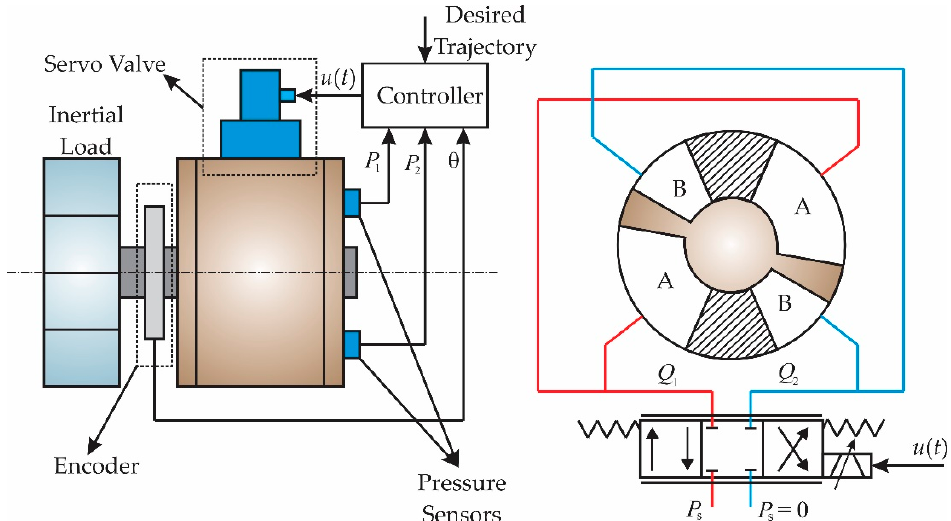
Figure 1. The hardware configuration and schematic diagram of the studied electro-hydraulic control system.